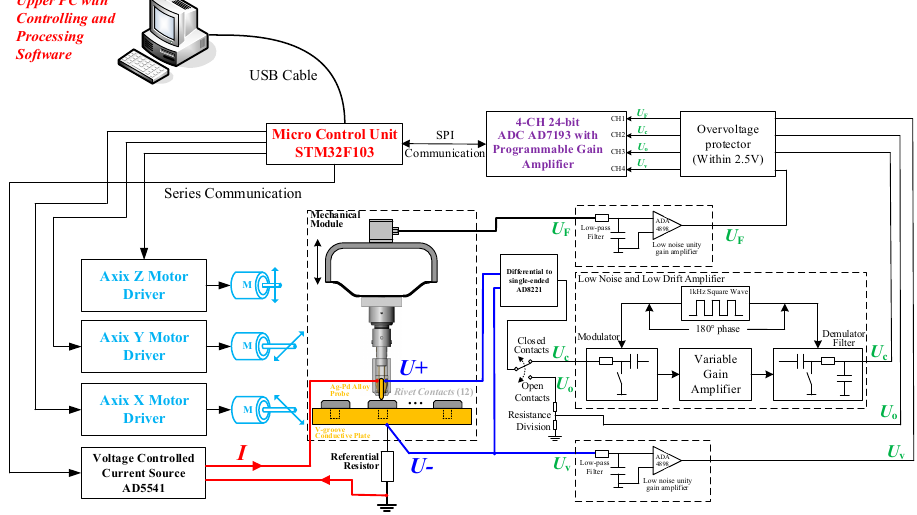
Figure 4. Schematic diagram of the electrical control and measurement system.